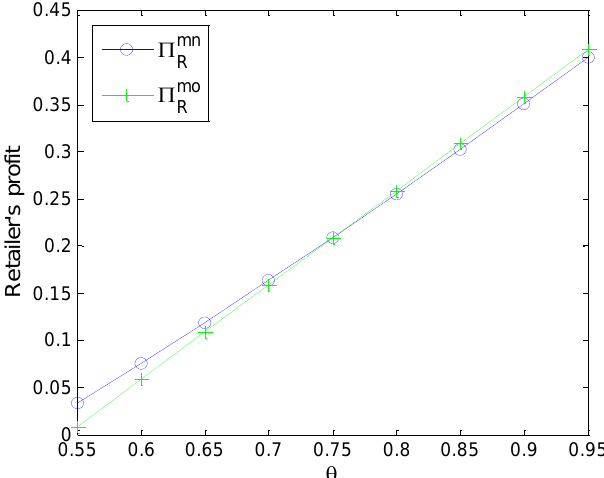
Figure 3. Impact of 𝜃 on retailer’s profits under monopoly case.